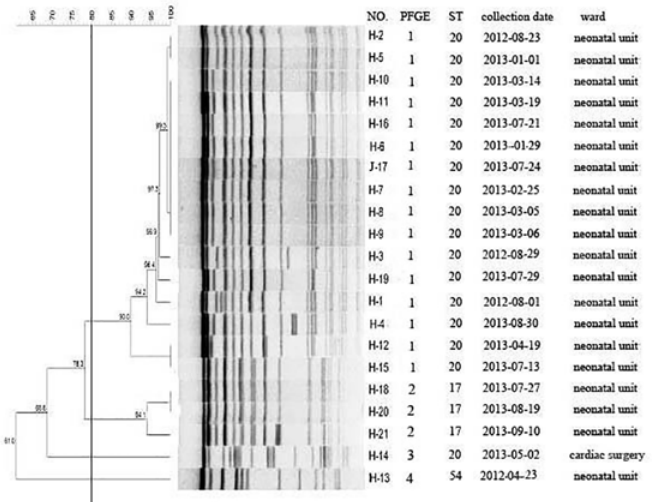
Fig 2. Dendrogram analysis. Dendrogram generated with the Fingerprinting II Informatix software package (Bio-Rad Laboratories, Hercules, CA) showing the relatedness of fingerprints (XbaI-PFGE) for 21 K . pneumoniae . The phylogenetic tree was constructed using the Dice coefficient and UPGMA clustering. A genetic similarity index scale is shown in the left of the dendrogram. PFGE types, strain number, collection data and wards distribution information are included along each PFGE lane. No.,